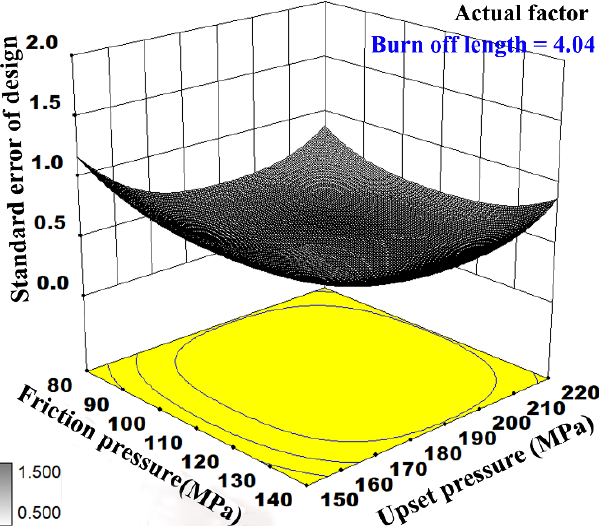
Figure 6. Standard error design of the actual parameters (experimental conditions).